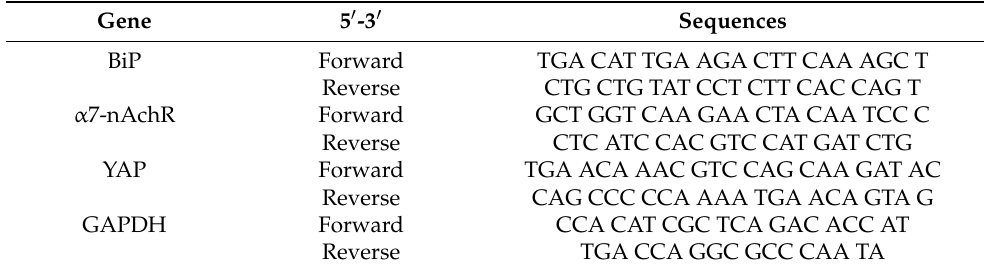
Table 1. The primer sequences used for quantitative RT-PCR.